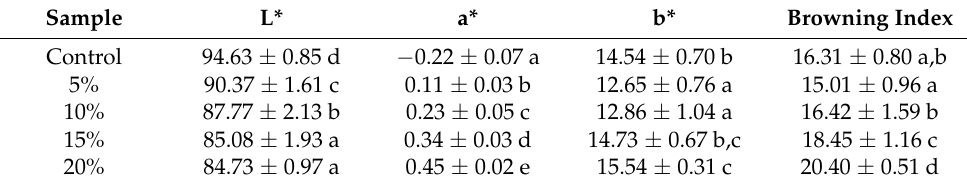
Table 3. The values of the color parameters of the crumb of gluten-free bread with the addition of chestnut flour in the amounts of 0, 5, 10, 15 and 20%. Sample L* a* b* Browning